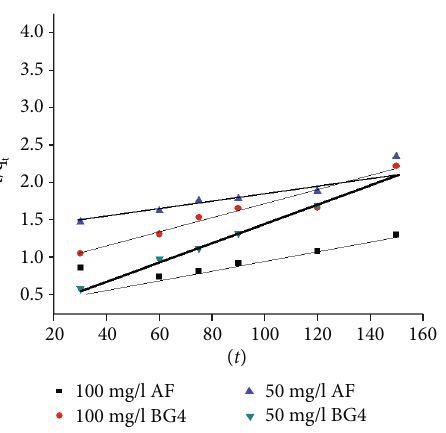
Figure 14: Pseudosecond order model for BG4 and AF adsorption onto HUAC.